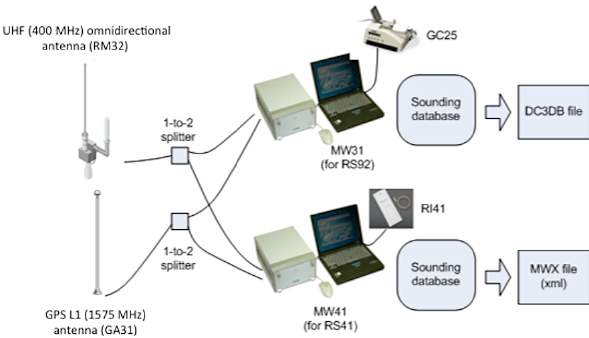
Figure 2. Experimental system setup: antennae, sounding system, and ground check